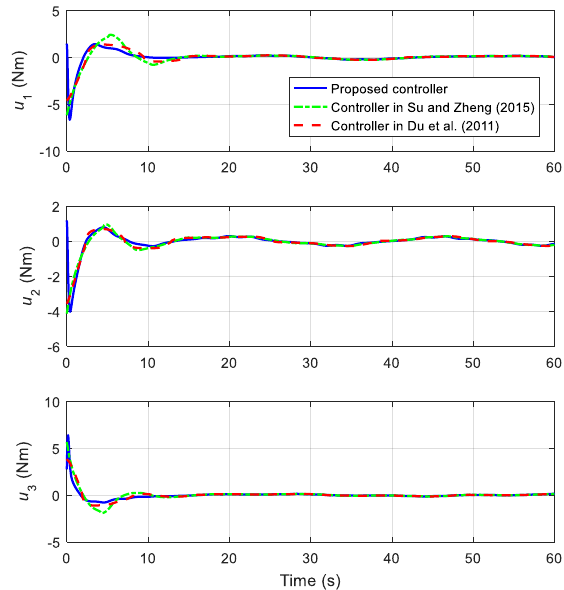
Figure 6. Profile of the control torques u [18,21].